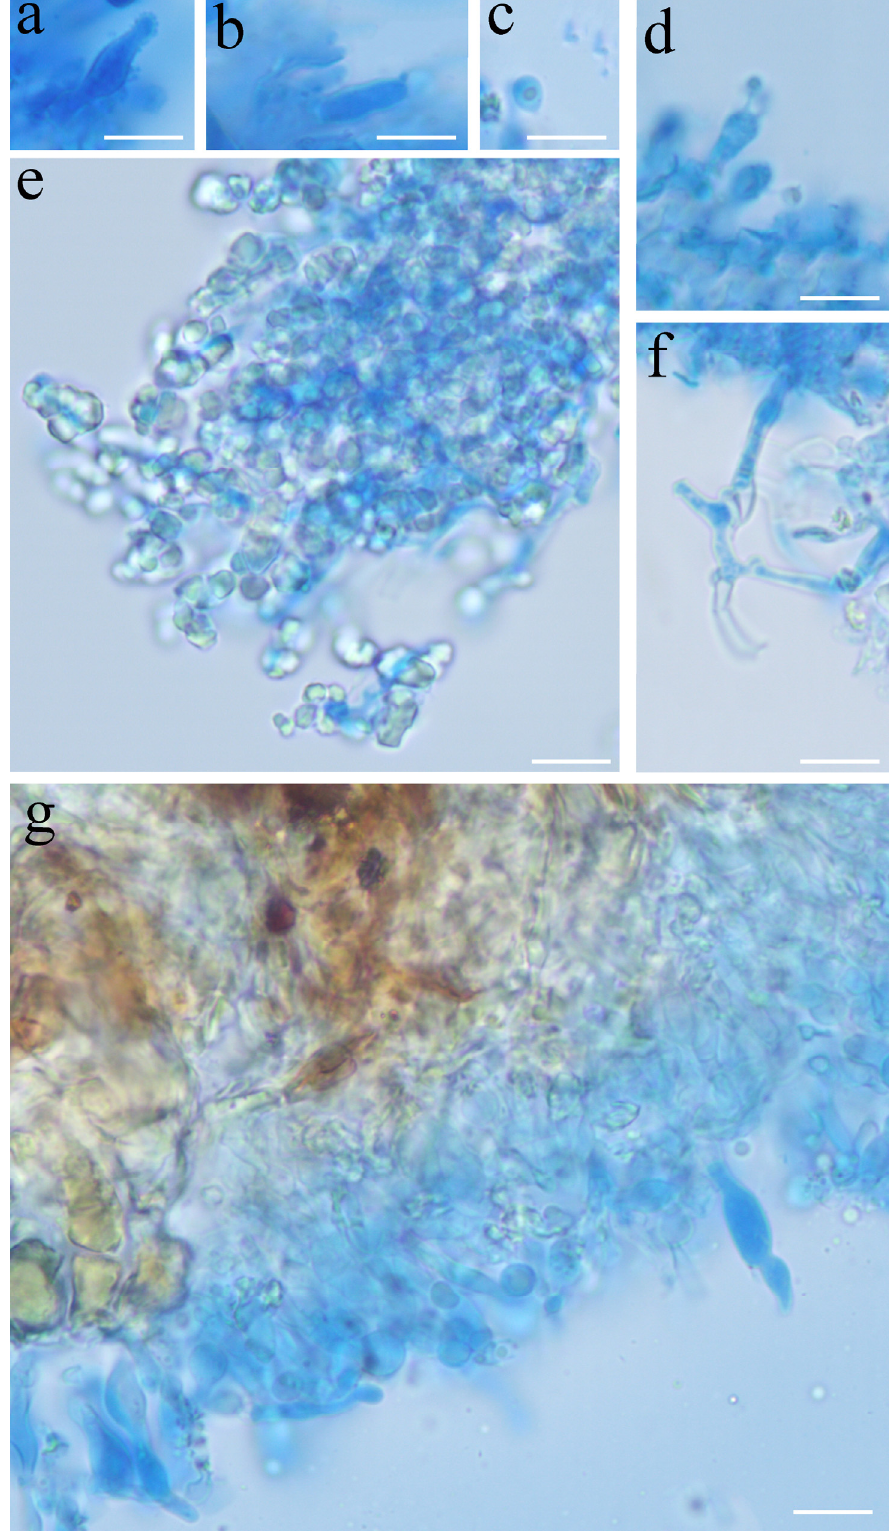
Figure 10. Microscopic structures of Xylodon sinensis (holotype) ( a ): fusiform cystidia ( b ), basidioles ( c ), basidiospores ( d ), basidia ( e ), crystal ( f ), and generative hyphae ( g ). A section of hymenium. Bars: a–g = 10 µm, 10 × 100 Oil.